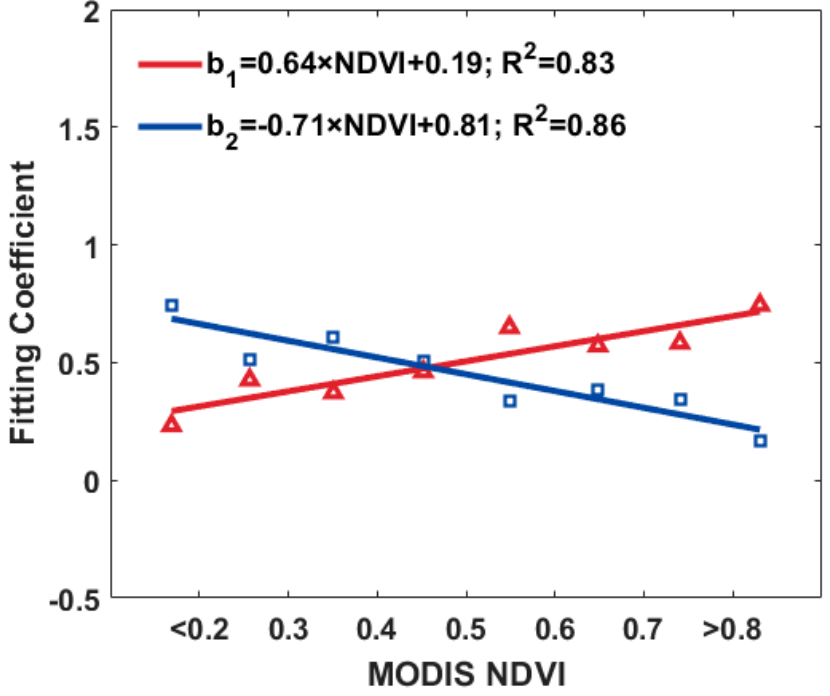
Figure 3. Relationship between regression coe ffi cients (i.e., b 1 , and b 2 ) and the MODIS